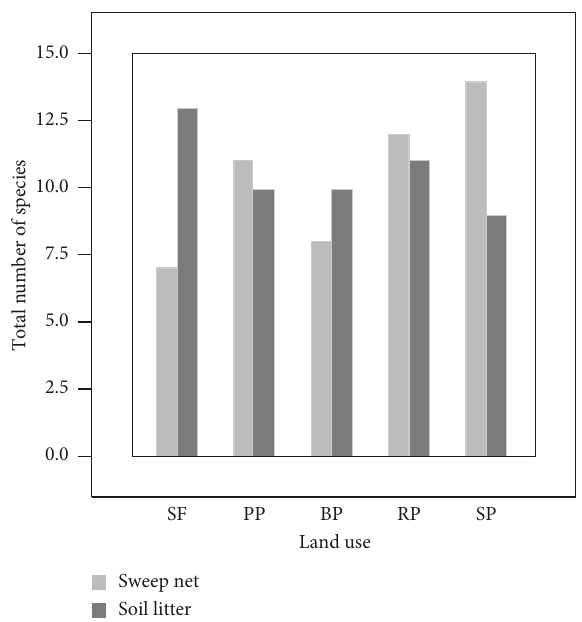
Figure 4: Total number of species captured from sweep nets and soil-litter extractions in the different land-use